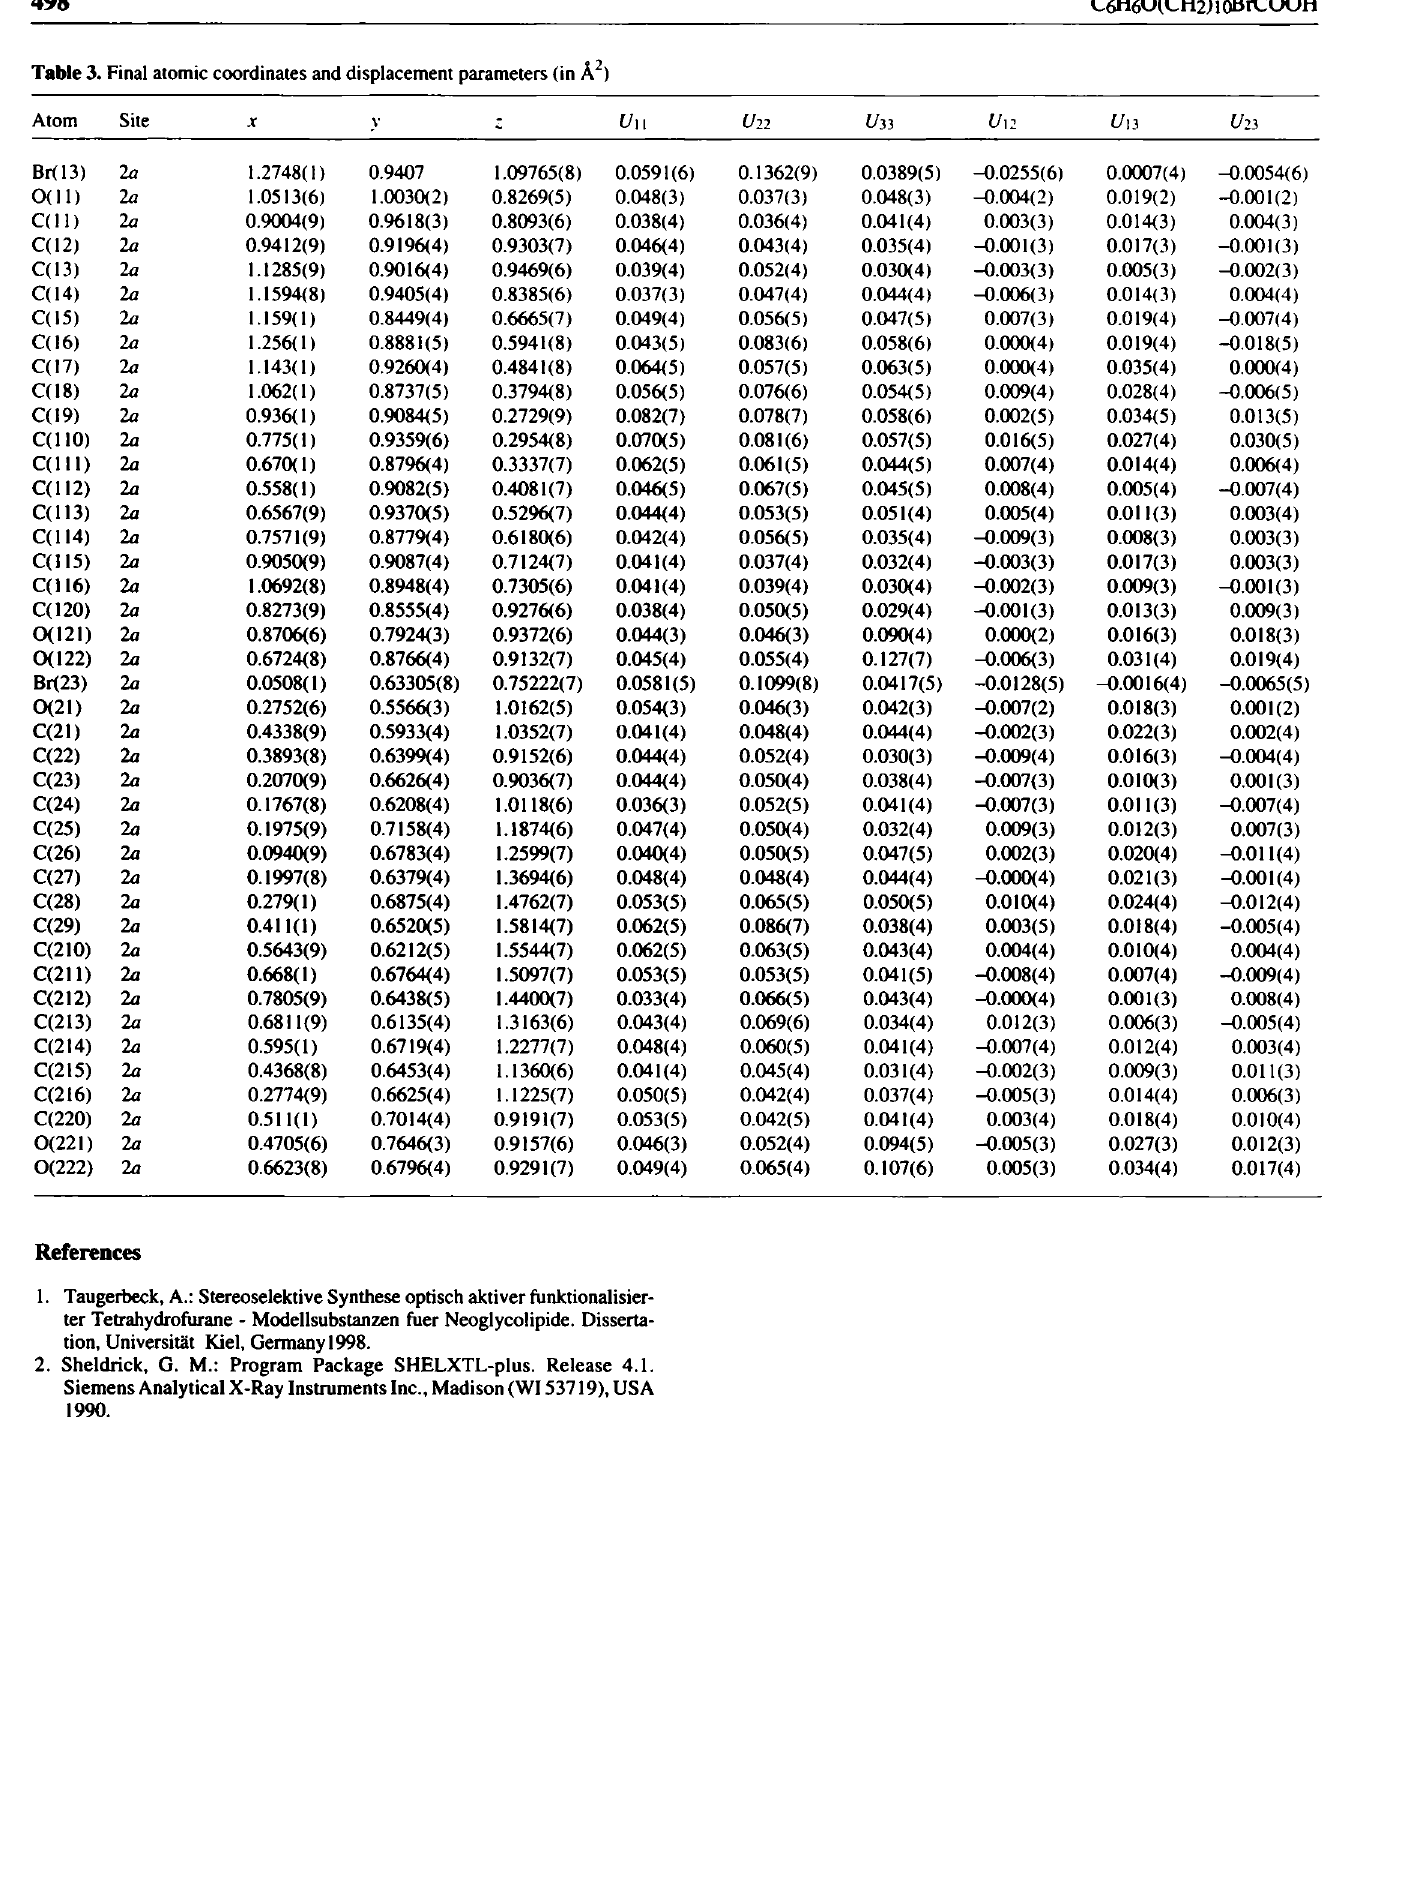
Table 3. Final atomic coordinates and displacement parameters (in Â^) Atom